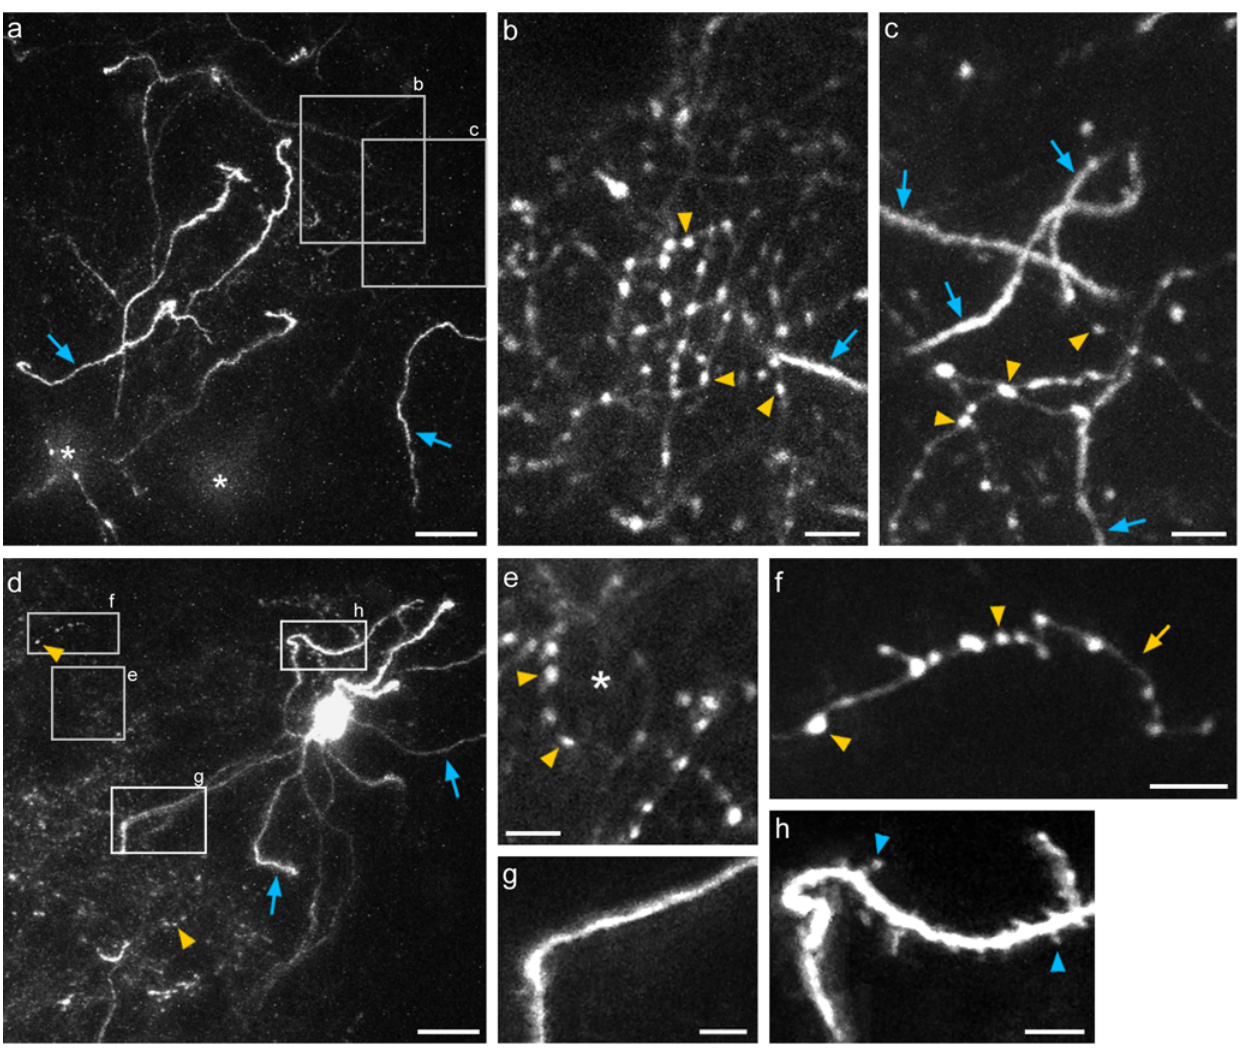
Figure 4. In-vivo 2-photon imaging of GFP-labeled basket interneurons in Pv-cre mice. (a) Low-magnification projection of a z-series starting at , 20 m m below the pia surface to a depth of , 120 m m, from a densely labeled area. The asterisks indicate the tops of two cell bodies. Numerous dendritic branches are indicated by blue arrows. (b–c) Higher magnification z-projections of regions highlighted in (a) at two different depths: 85–90 m m (b) and 65–75 m m (c) below the pia. Note the smooth, aspiny dendrites (blue arrows), and dense cluster of boutons of varying size (yellow arrowheads). (d) Projection of a z-series 60–170 m m below the pia from a sparsely labeled area, showing an isolated GFP-labeled basket interneuron. Dendrites (blue arrows) could be traced back to soma, and axonal boutons (yellow arrowheads) appear as a cloudy signal at this magnification. (e–f) Examples of axon morphology magnified from areas indicated by gray boxes in (d). (e) shows an axonal basket-like structure (asterisk), and (f) shows a well-isolated axon branch (yellow arrow) with distinct boutons (yellow arrowheads). (g–h) dendrite structures from areas indicated in (d). Dendrites of the cell were largely aspiny (g), though occasionally small protrusions were visible on some dendritic branches (h). Scale bars a,d: 20 m m; b–c, e–h: 5 m